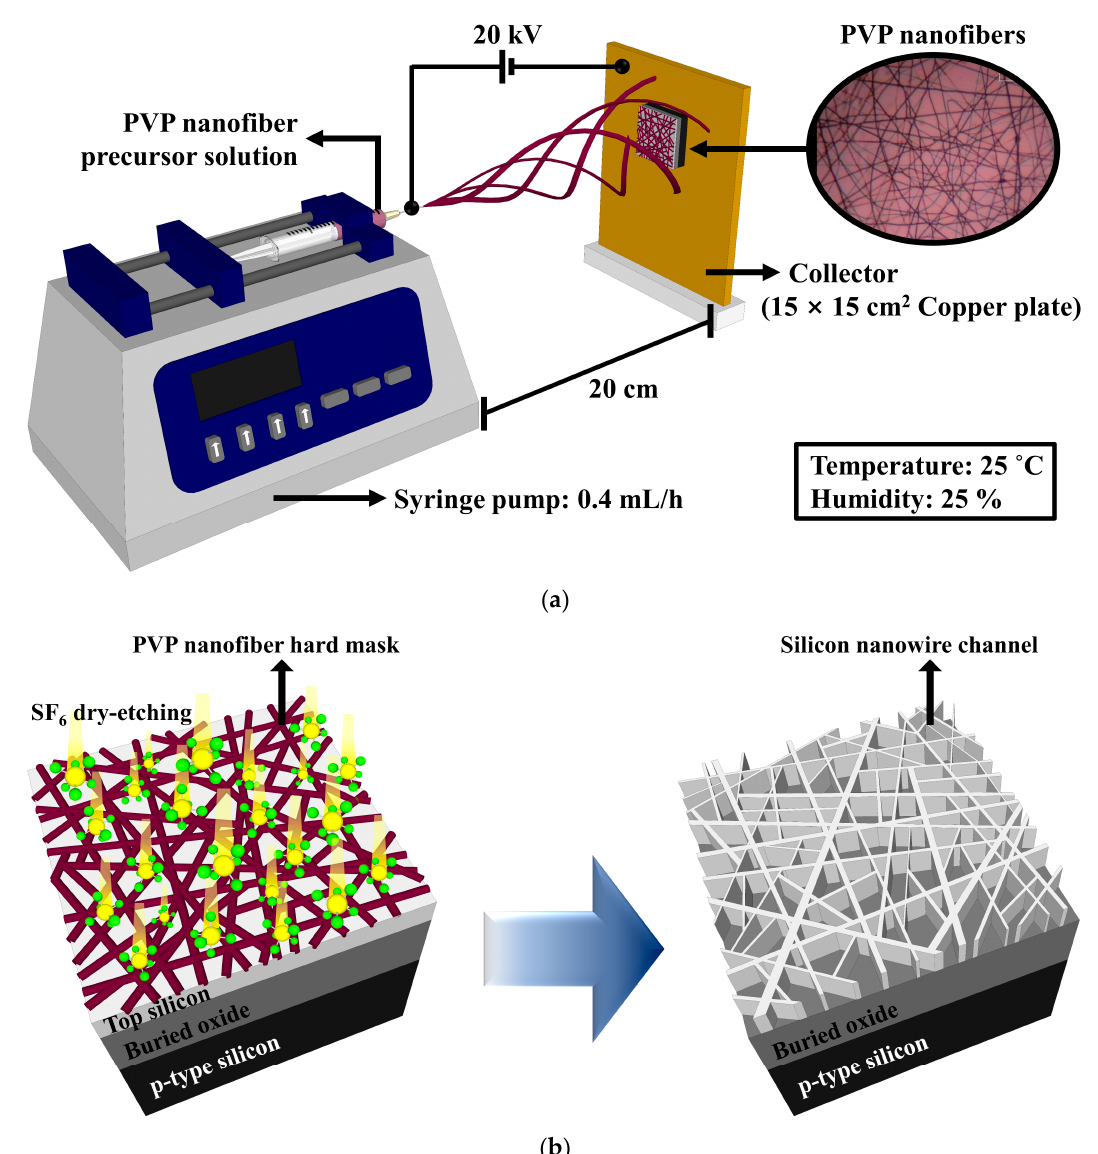
Figure 1. ( a ) Schematic of the electrospinning system. ( b ) Fabrication of SiNWs on an SOI substrate.